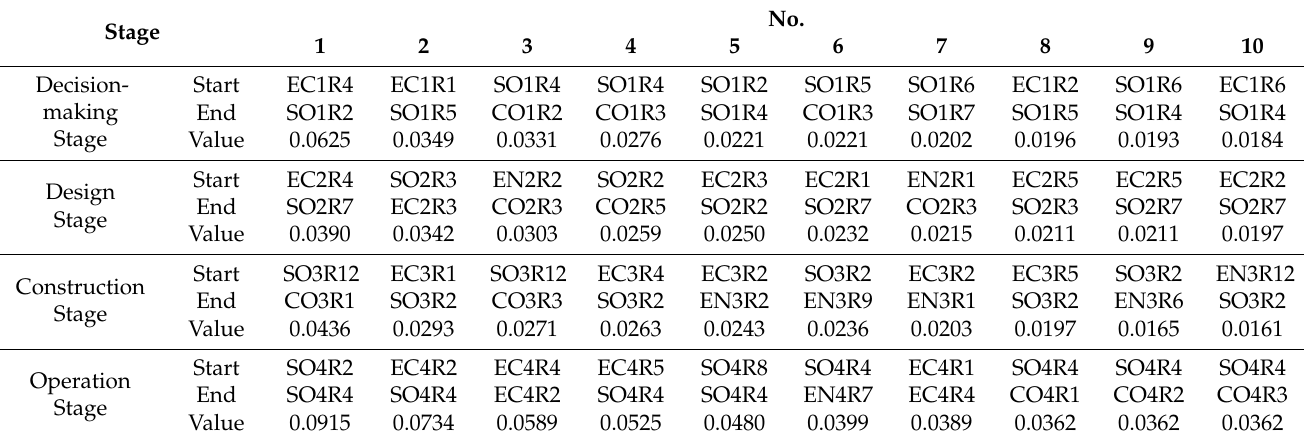
Table 7 ranks the top ten key risk links in each stage by link betweenness centrality. Table 7. Key risk